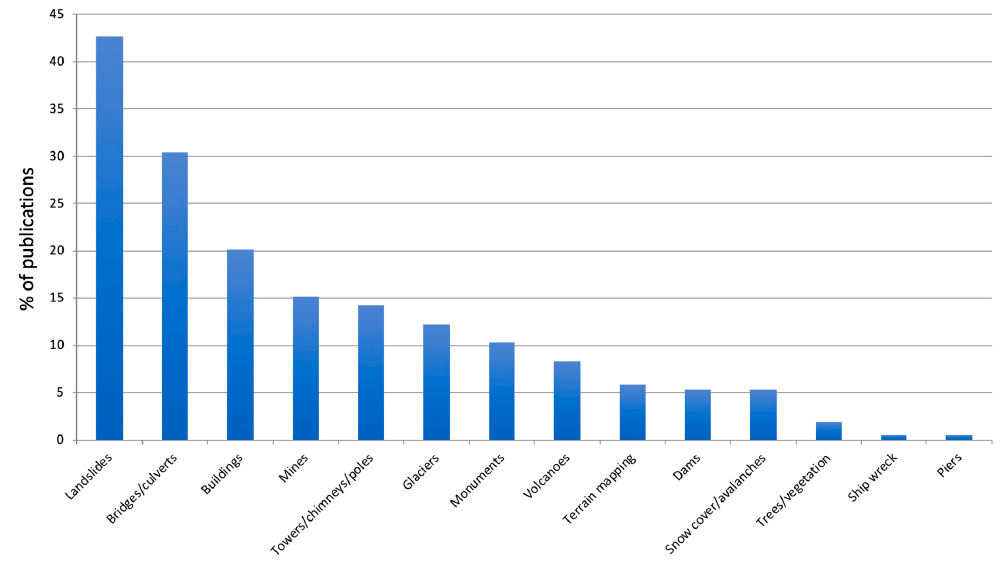
Figure 7. Papers published until December 2018 classified on the basis of their applications.